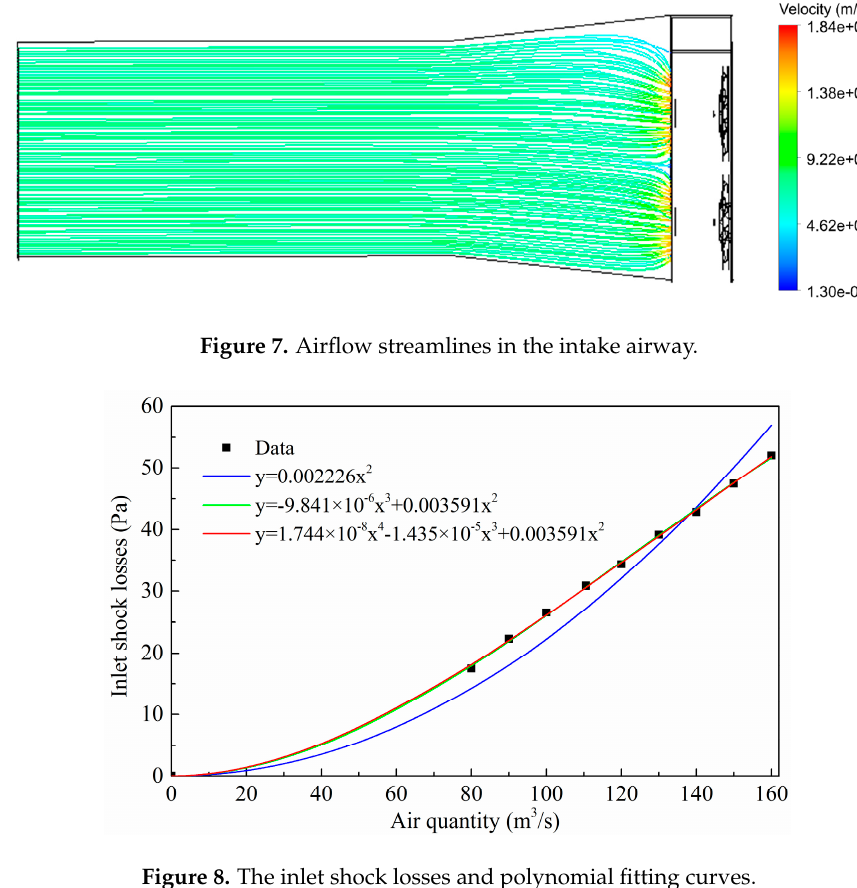
Figure 8. The inlet shock losses and polynomial fitting curves.